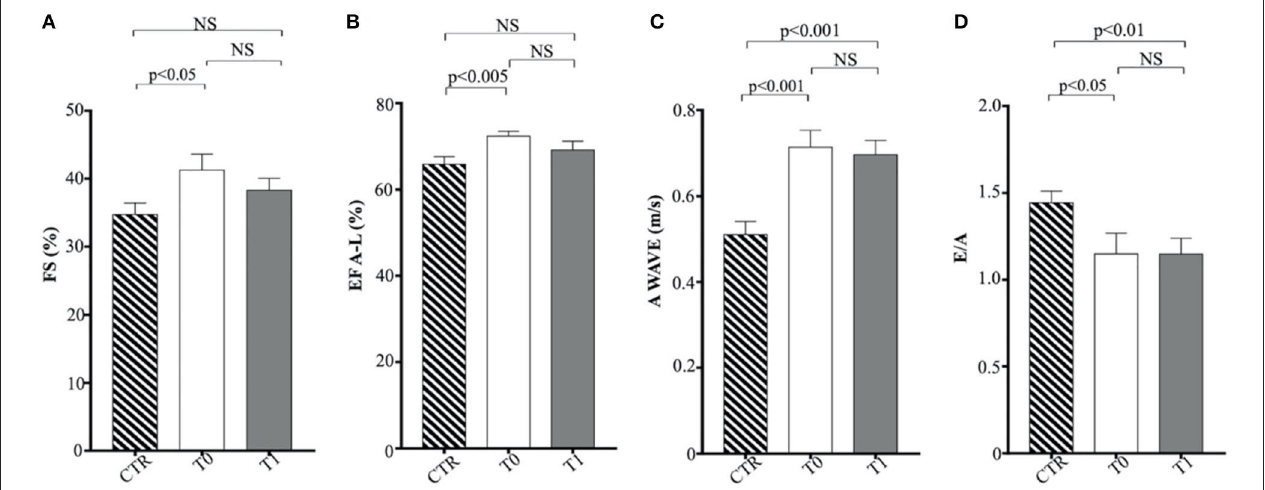
FIGURE 6 | Echocardiographic parameters in enrolled dogs. (A) FS, fractional shortening; (B) EF (A–L), ejection fraction calculated with area-length method; (C) A wave, A wave peak velocity; (D) E/A, ratio of peak early to peak late left ventricular inflow velocities. Control (CTR) group, dashed column; obese dogs at T0, white column; obese dogs at T1, gray column. Statistics: Wilcoxon matched-pairs signed-rank test was used for T0 and T1 comparation in obese dogs, while Mann–Whitney test was performed for the comparation between T0 obese dogs and CTR subjects. NS means not significant